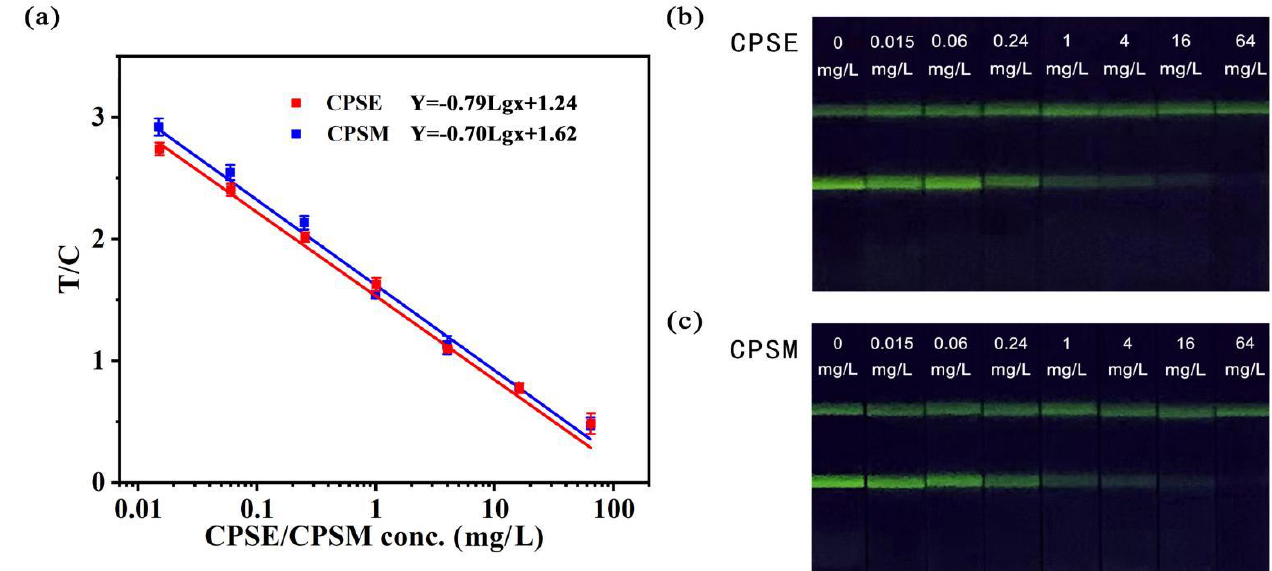
Table 2. Comparison of immunoassay for the detection of CPS.